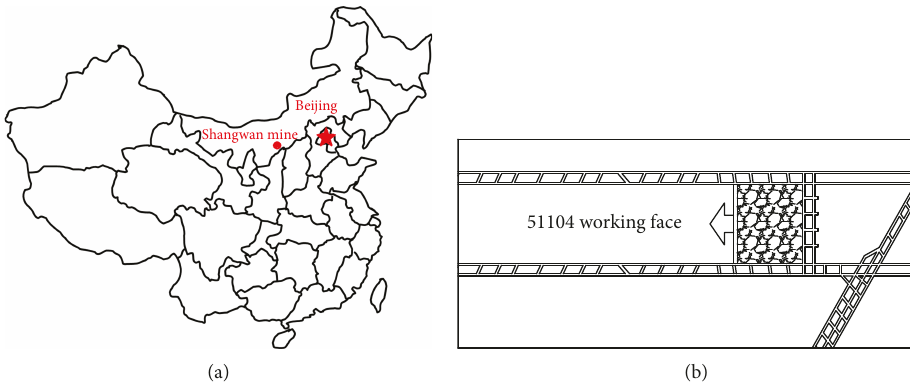
Figure 1: Shangwan coal mine and 51104 working face. (a) Shangwan coal mine location. (b) 51104 working face arrangement.